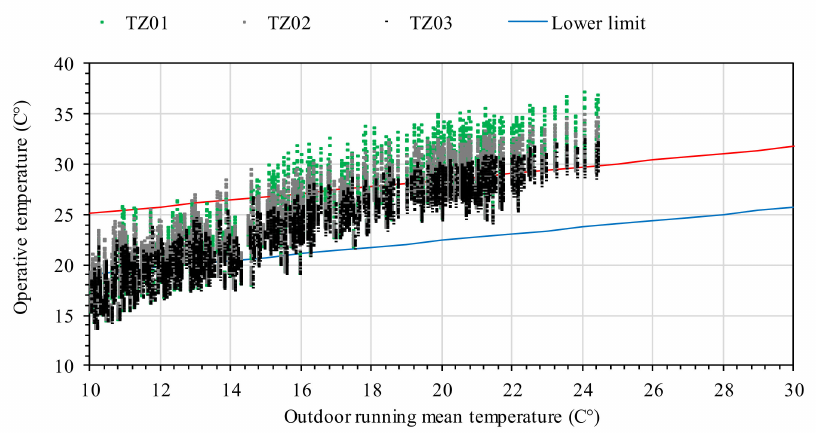
Figure 13. Thermal comfort analysis using EN16798-1 for Scenario C.